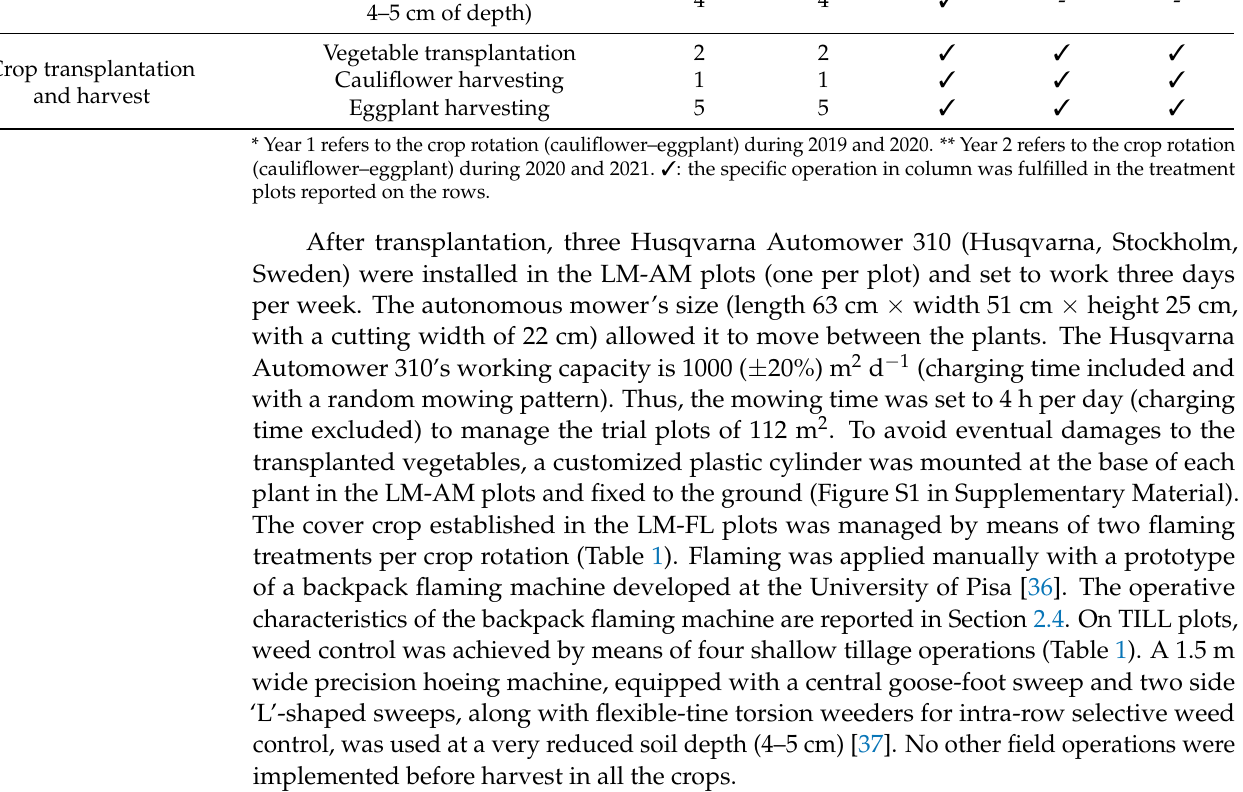
Number of Operations Year 1 * Year 2 ** TILL LM-FL